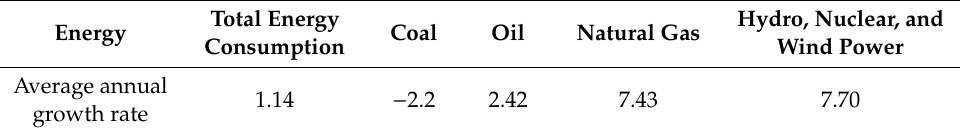
Table 15. Average annual growth rate